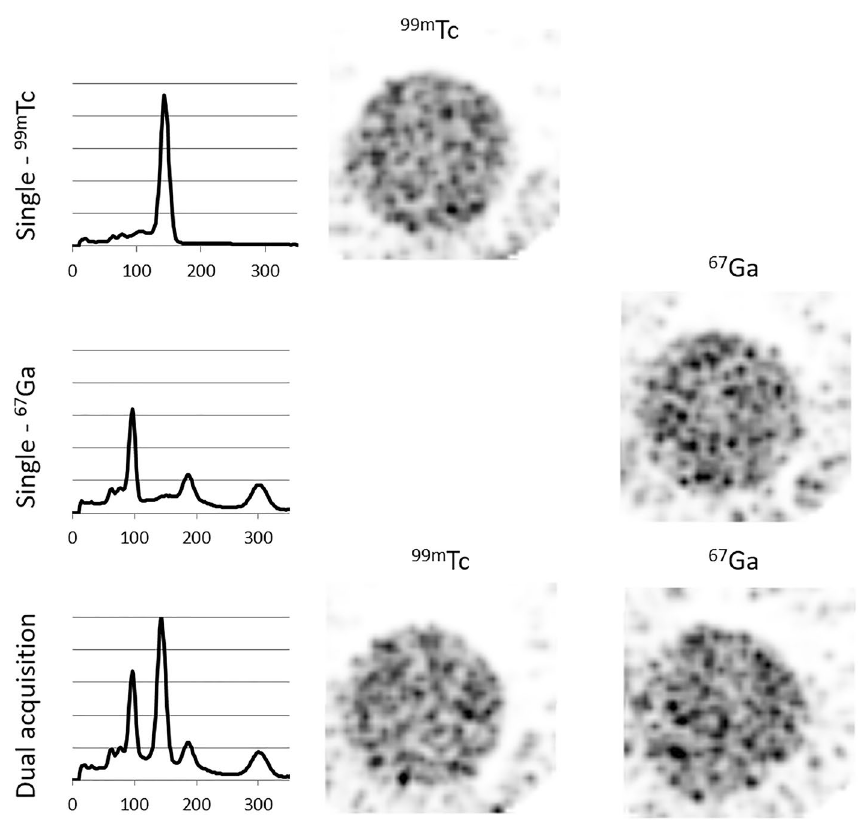
Figure 3. Spectra and images obtained with the single (first and second rows) and dual isotope (bottom) acquisitions with the UHS-M